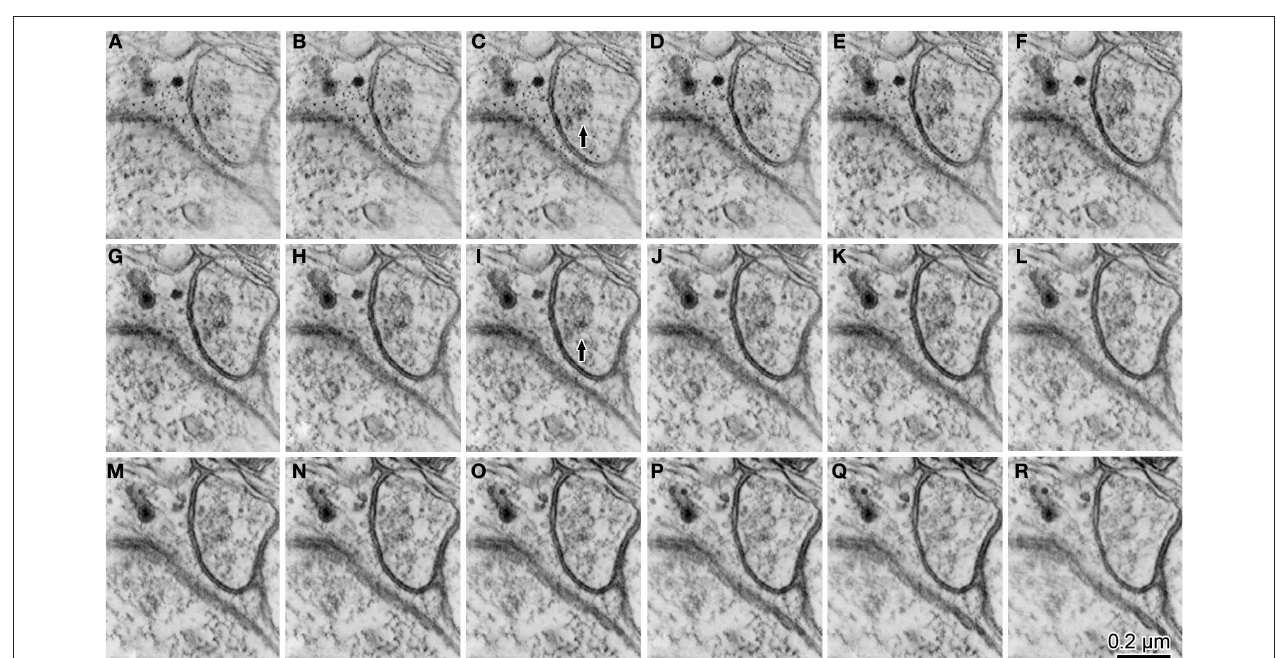
asterisks in image ( C )] emerges continuously from the location where most synaptic boutons were found in the previous ultrathin section. Highly electron dense fl occulate substance [for example; arrows in ( C, I, O )], PSD, emerged at the edge of the intermediate one [arrows in ( C )]. It gradually took over the domain of the intermediate electron dense fl occulate substance ( A–R ).